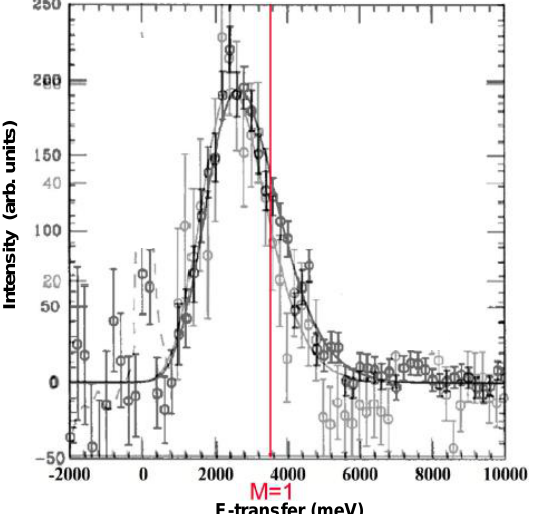
Figure 3. Deep-inelastic neutron scattering (DINS) from chemisorbed H in C 8 K; data adapted from [21]. The maxima of the H peaks are about 2620 meV The vertical (red) line shows the position of the M = 1 a.m.u. recoil peak (at 3540 meV), assuming that the conventional theory, in particular the IA, is valid. Black points and fitted line: KH, Grey points and fitted line: C 8 K 0.9 H 0.13 . The spectra were recorded with a selected final neutron energy E f = 4280 meV. The peak maxima correspond to M ef f = 1.2 a.m.u. (Reproduced from Ref. [22], with permission from Institute of Physics